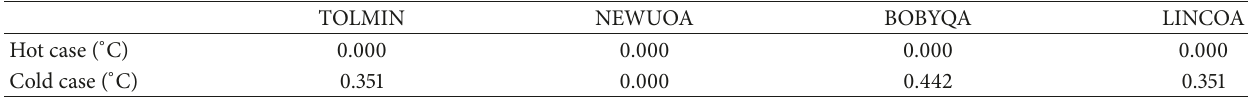
Table 3: Error values achieved with Powell’s algorithms for steady-state cases ( ∘ C).